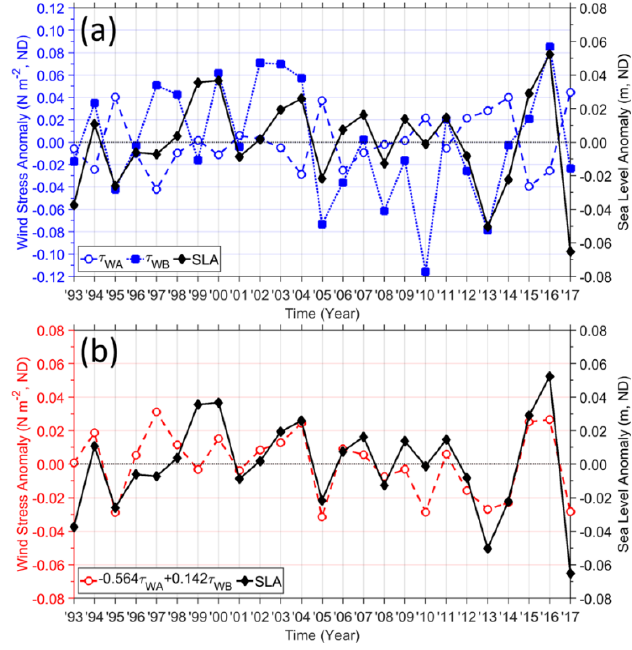
Figure 7. Time series of ( a ) southeastward wind stress anomalies in the WA (blue dashed line, left y-axis) and WB (blue dotted line, left y-axis), ( b ) multiple linear regression results from southeastward wind stress anomalies in the WA and WB on the NEAMS-mean sea level anomalies (red dashed line, left y-axis), and ( a , b ) winter NEAMS-mean sea level anomaly observed from satellite altimetry (black line, right y-axis) from 1993 to 2017. The correlation coe ffi cients of the NEAMS-mean sea level anomalies with wind stress anomalies in the WA and WB are − 0.67 ( p -value < 0.01) and 0.57 ( p -value < 0.01) while that with multiple linear regression is 0.70 ( p -value <